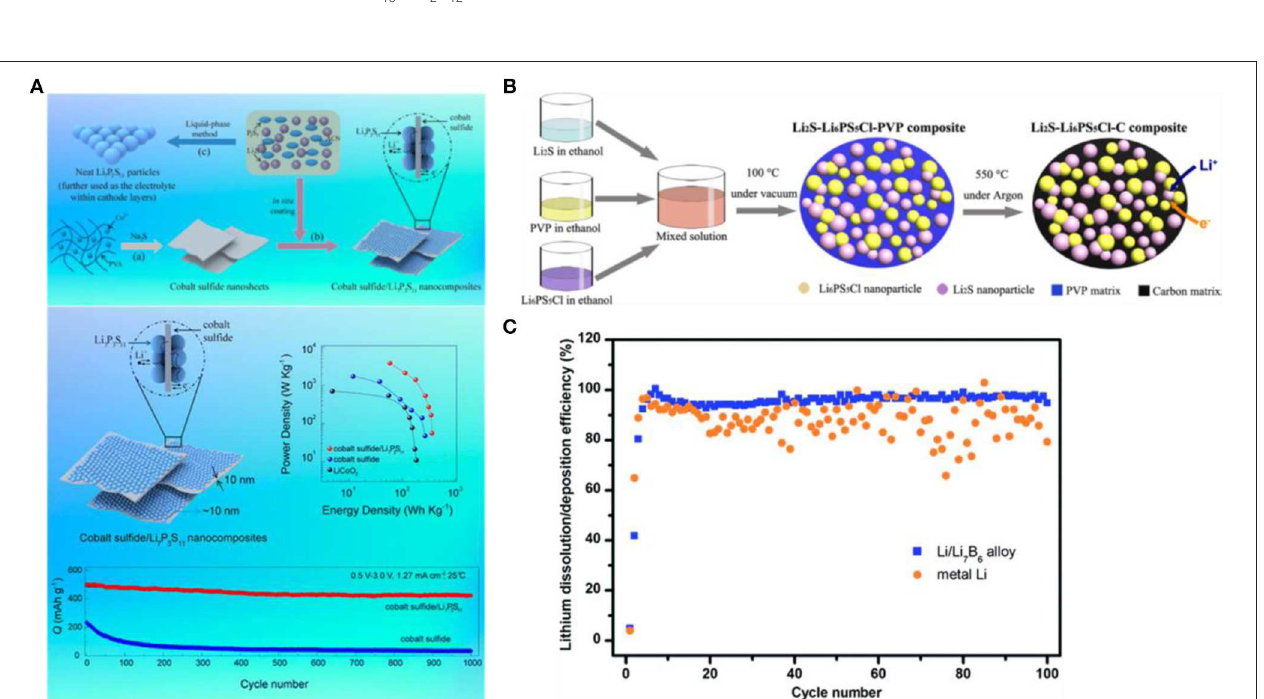
FIGURE 6 | Sulfur cathode and Lithium anode design for solide state Li-sulfur batteries. (A) Schematic illustration of the synthesis strategy for cobalt sulfide, cobalt sulfide–Li 7 P 3 S 11 nanocomposites, and neat Li 7 P 3 S 11 electrolyte. Reproduced with permission (Lin et al., 2013a). Copyright 2016, Nano Letters. (B) Schematic illustration of the bottom-up synthesis of the mixed conducting Li 2 S nanocomposite. Reproduced with permission (Yu et al., 2004). Copyright 2016, Nano Letters. (C) Cycling efficiency of lithium deposition/dissolution for Li-B alloy (30 wt% B) and metallic Li electrodes. Reproduced with permission (Bucur et al., 2016). Copyright 2014, Journal of Materials Chemistry A.